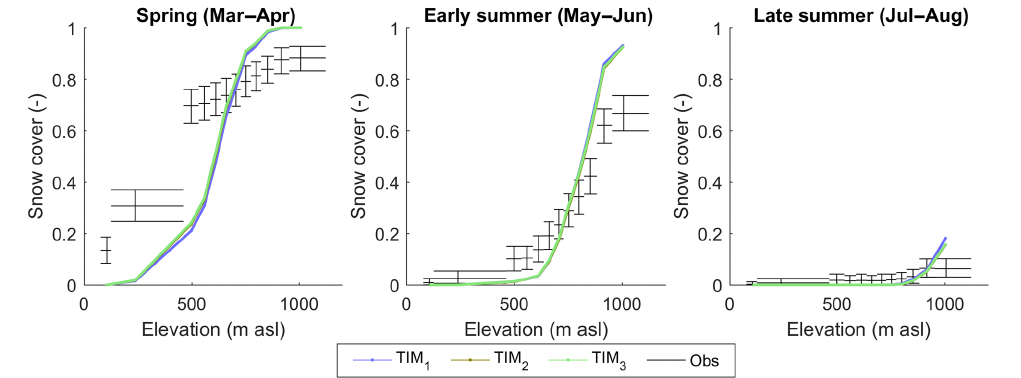
Figure 12. Simulated seasonal snow distribution curves when using the three melt model structure.